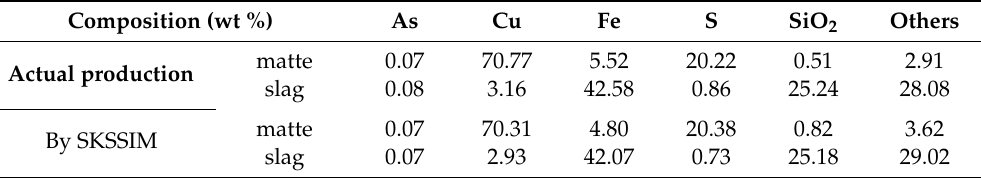
Table 1. Chemical composition of matte and slag.